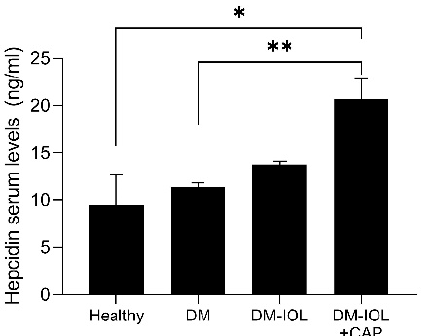
Figure 3. Serum hepcidin levels in healthy rats and in rats with diabetes (DM) and experimental iron overload (IOL), untreated or treated with capsaicin (CAP). Data are expressed as the mean ± standard error. * p < 0.05, ** p < 0.01, ANOVA and post-hoc Bonferroni test.